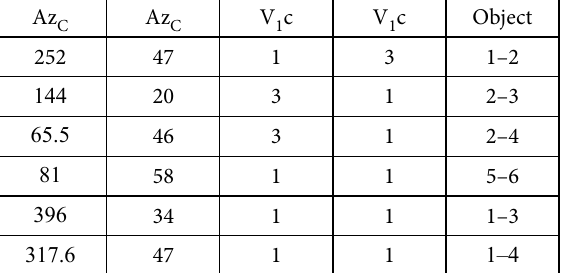
Fig. 18. Sample of reference object and its Table 3. Differences between the values obtained for calculated parameters in the reference and target